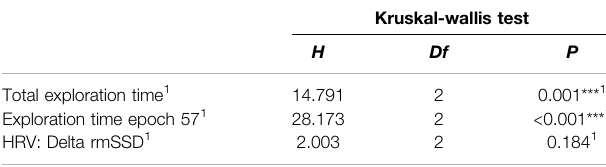
TABLE 2 | Test statistics for Kruskal-Wallis test regarding exploration time and HRV